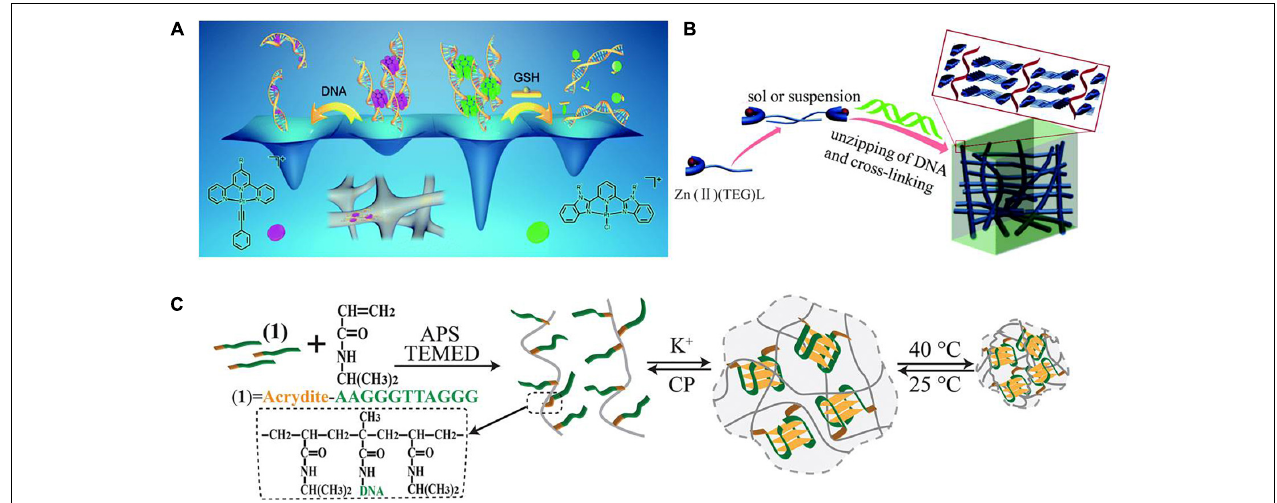
FIGURE 3 | (A) Schematic diagram of using platinum(II) complexes as electrostatic crosslinking agents for the construction of DNA-based supramolecular hydrogels. Reproduced with permission from Zhang et al. (2020). Copyright (2020) The Royal Society of Chemistry. (B) Schematic diagram of using Zn 2 + complexes for the preparation of DNA-based instant hydrogels by coordination interaction. Reproduced with permission from Geng et al. (2019). Copyright (2019) The Royal Society of Chemistry. (C) Schematic diagram of the preparation of K + -stabilized G-quadruplex–crosslinked DNA-based dual-stimuli-responsive PNIPAM hydrogel. Reproduced with permission from Lu et al. (2015). Copyright (2015) The Royal Society of